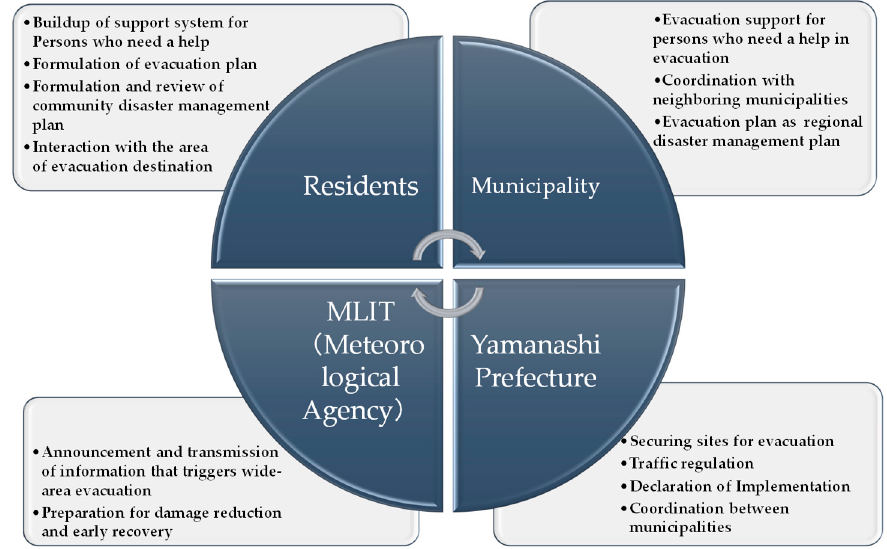
Figure 9. Roles that stakeholders, such as local and national governments, should play in the wide-area evacuation plan proposed by the